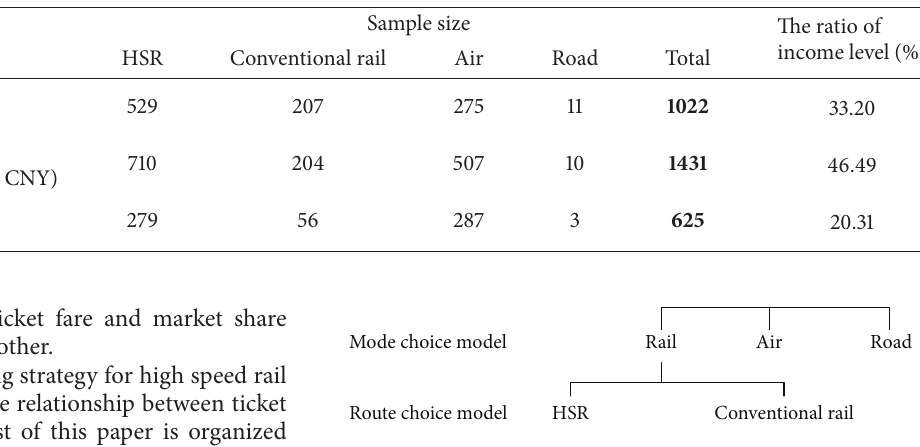
Table 1: Mode split in the sample for different income levels.